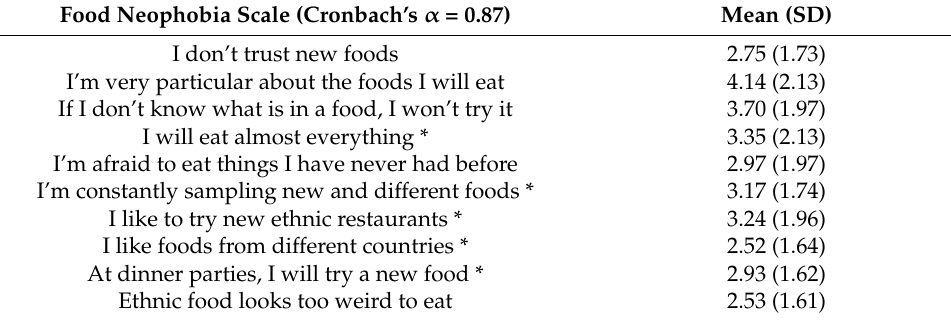
Table 2. Descriptive statistics of the Food Neophobia